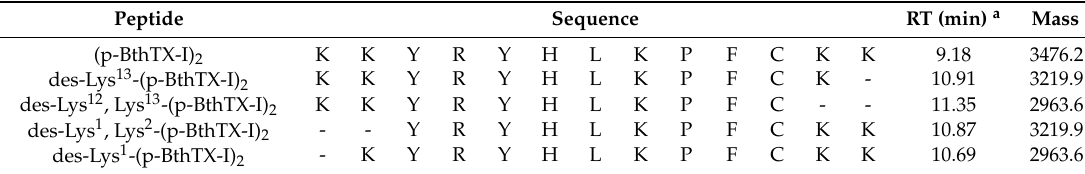
Table 1. Characteristics of the synthetic